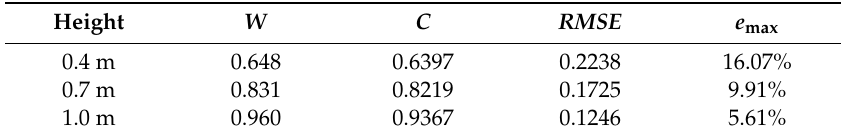
Table 3. Regression analysis of the acquisition system in the same layer at di ff erent heights from the ground.